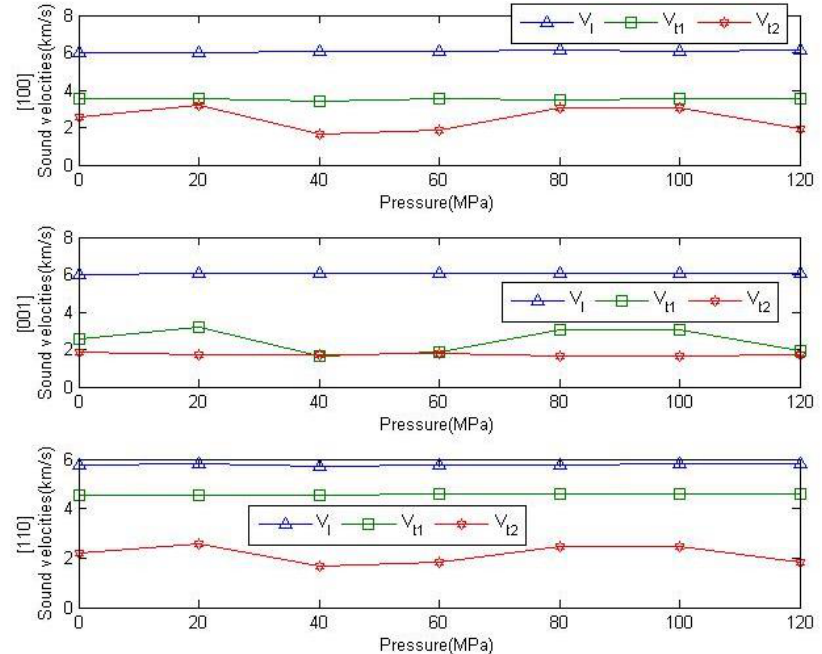
Figure 12. Relationship between wave velocity and pressure in the [100], [001] and [110] directions of anhydrite crystals.